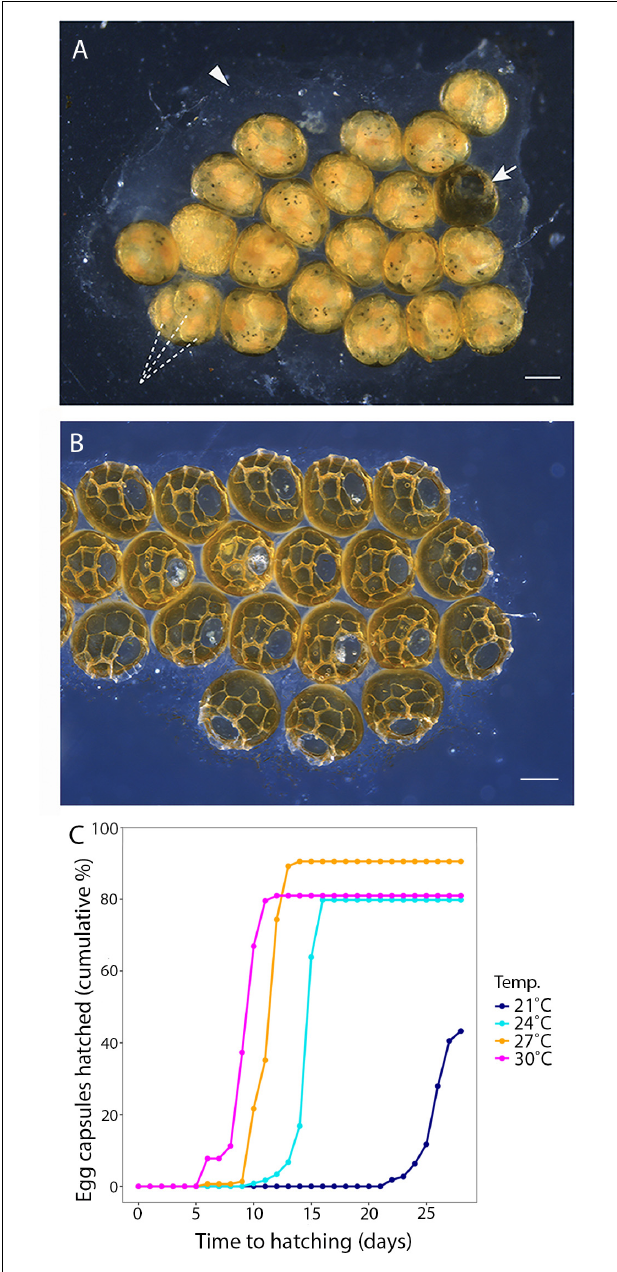
FIGURE 2 | (A) A P. acroporae egg cluster showing multiple embryos (dashed lines) inside each egg capsule (arrow points to a hatched capsule), cemented to the substrate (arrowhead) (scale = 200 µ m). (B) An egg cluster showing capsules after the hatchlings have emerged. (C) A cumulative hatching plot showing the effect of temperature on embryonation period and hatching success ( n = 125 egg capsules at 21 ◦ C, n = 124 egg capsules at 24 ◦ C, n = 144 egg capsules at 27 ◦ C, n = 129 egg capsules at 30 ◦ C; nine replicate egg clusters per temperature).